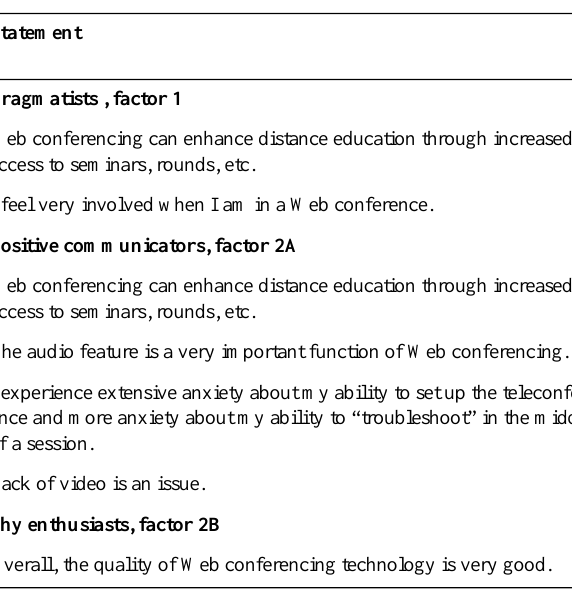
Table 5. Statements with extreme scores for each factor*